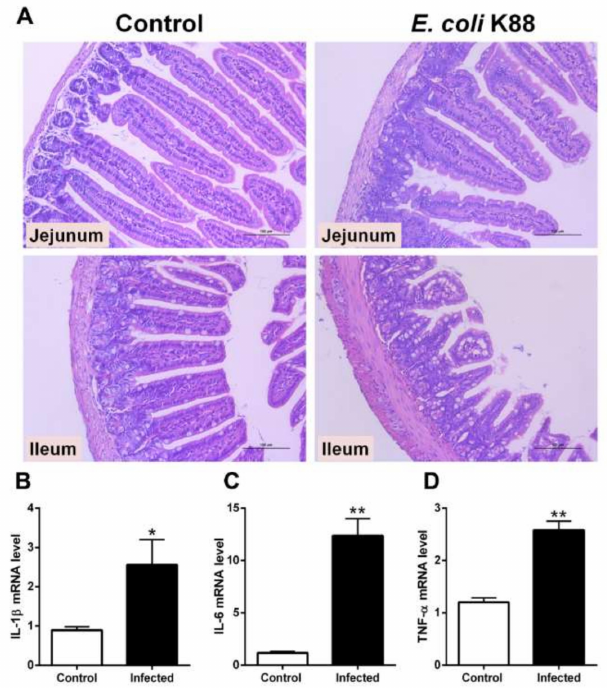
Figure 1. Inflammatory responses to E. coli K88 infection. ( A ) Representative H&E-stained section from the jejunum and ileum of mice. Original magnification 400 × . In challenged mice, the ileum and jejunum were seriously damaged with discontinuous brush border and short intestinal villi. ( B – D ) E. coli K88 infection promoted the mRNA expression of IL-1 β , IL-6 and TNF- α in mice liver. Data are presented as the mean ± SD, n = 6. The values were normalized against the level of GAPDH gene. * Indicates a significant di ff erence ( p < 0.05) and ** Indicates an extremely significant di ff erence ( p < 0.01) compared to that of control